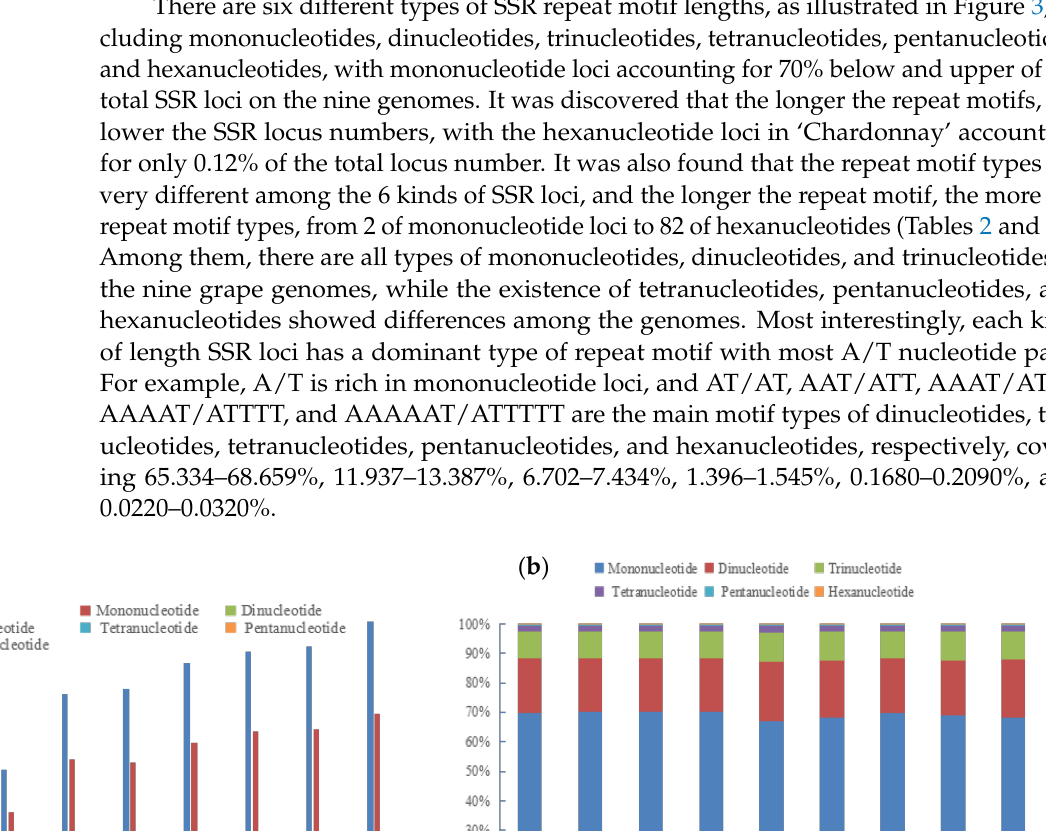
Figure 2. Number and density distribution of SSRs on 19 chromosomes in the genome of cv. ‘PN40024’. The bar graph shows the number of SSR loci. The linear graph shows the density of SSR loci. The horizontal ordinate is chromosome number, vertical coordinates are number of SSR motifs and SSR motif density, respectively.